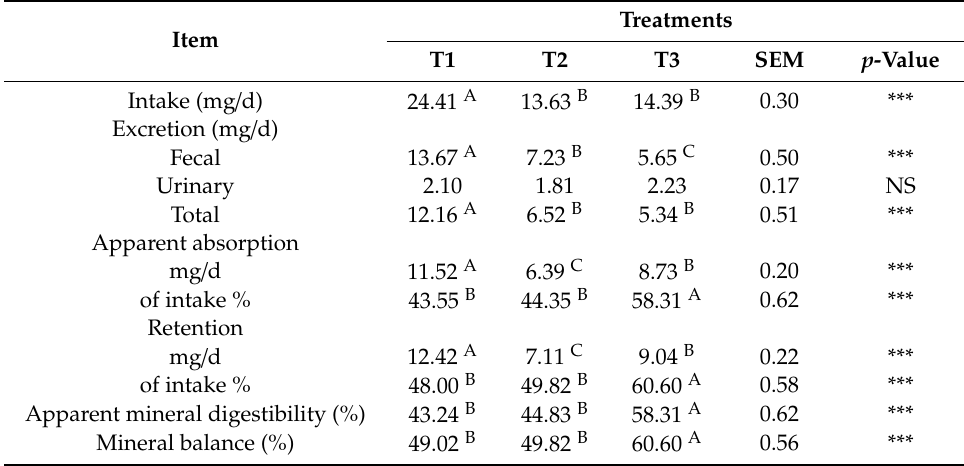
Table 4. Zinc balance by Dorper lambs fed with di ff erent levels of